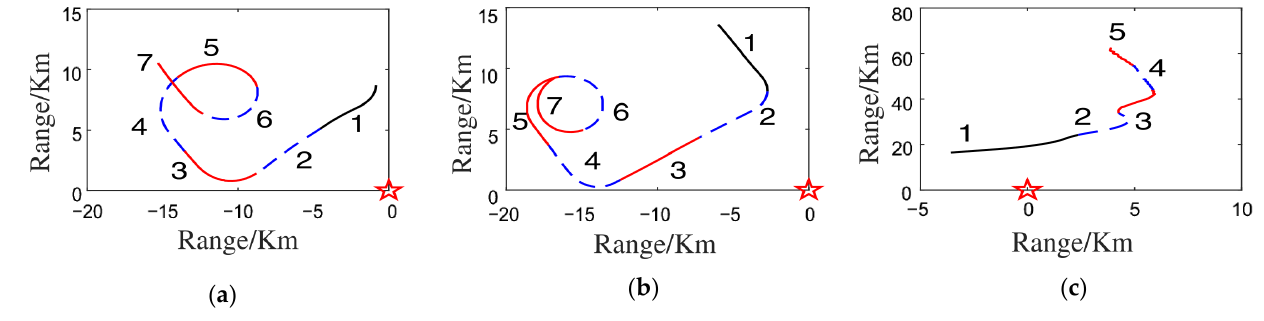
Figure 6. Optical images and typical HRRPs of ( a ) An-26; ( b ) Cessna Citation S/II; ( c ) Yak-42.